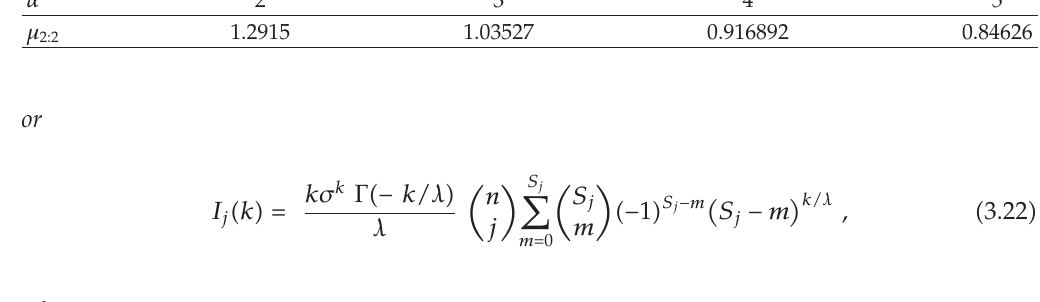
Table 3: The moments μ 2:2 arising from iid Exponentiated Frechet r.v.’s. using (cid:2) 3.3 (cid:3) or (cid:2) 3.5 (cid:3) . α 2 3 4